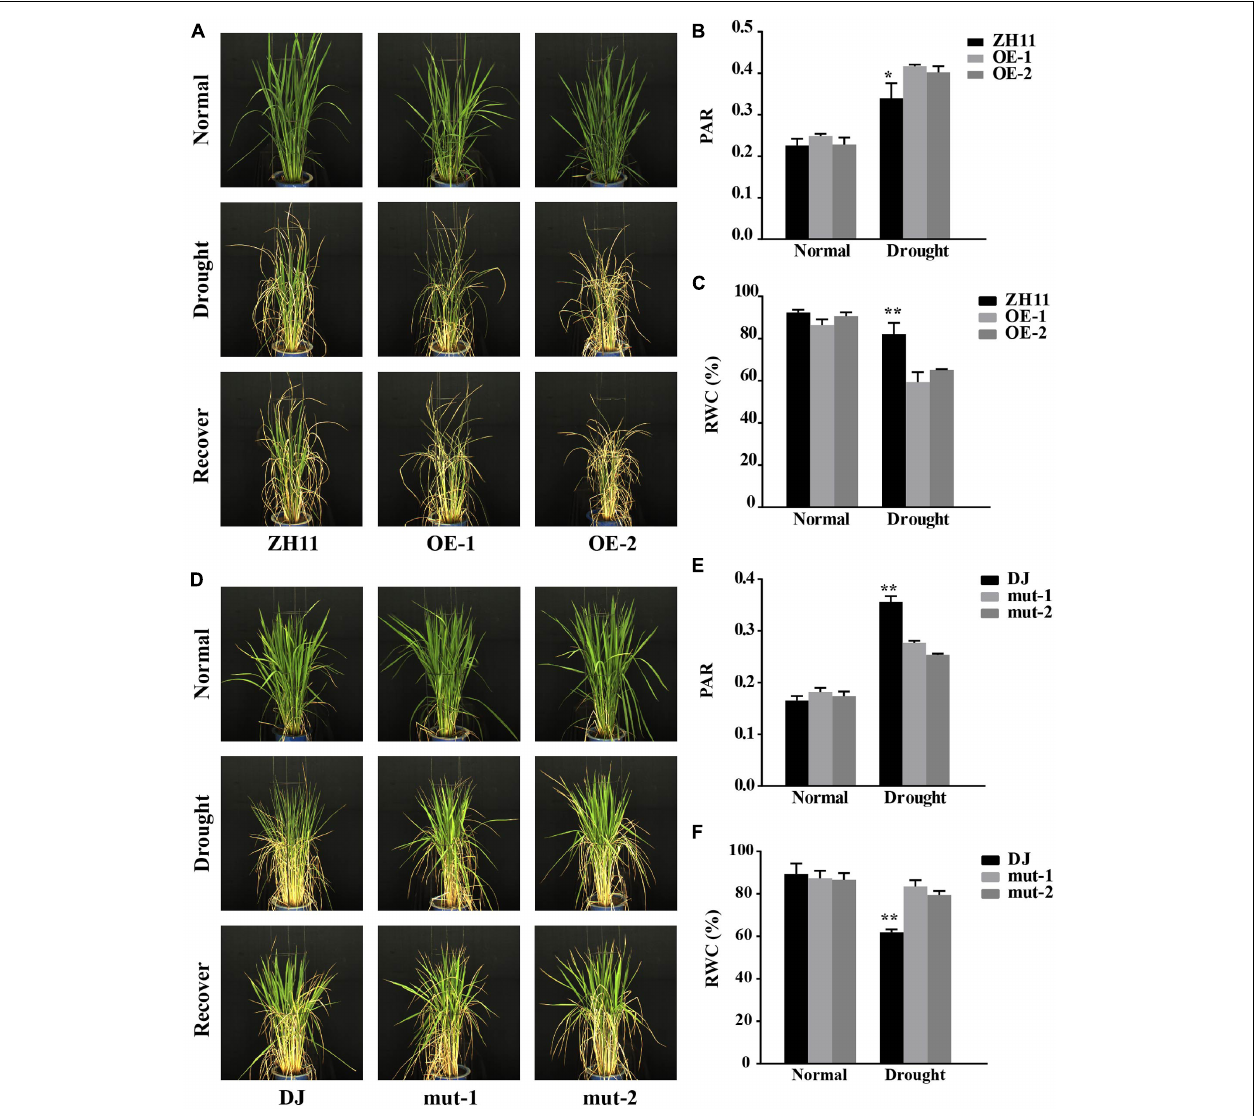
FIGURE 3 | Drought resistance testing of the OsJAZ1 -OE and mutant lines at the reproductive stage. (A) The OsJAZ1 -OE lines and the WT plants grown in barrels at the booting stage were subjected to drought stress treatment for 7 days with the soil moisture content maintained at 15%. The degree of leaf rolling is indicated by the PAR (B) and the relative water content (RWC) (C) of the OsJAZ1 -OE lines under normal and drought stress conditions. PAR = plant perimeter/plant projected area. (D) The jaz1 mutant lines showed increased drought resistance. PAR (E) and RWC (F) of the jaz1 mutant lines and Dongjin under normal and drought stress conditions. Error bars represent the SE of three replicates ( ∗∗ P < 0.01, ∗ P < 0.05, Student’s t